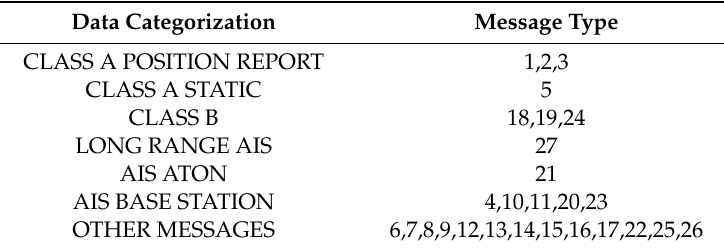
Table 2. Categorization of AIS message